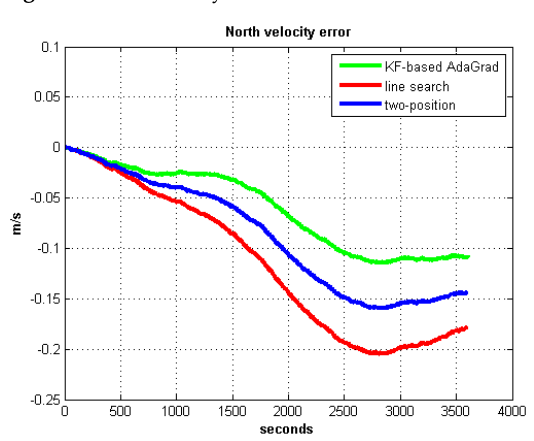
Figure 7. East velocity error.